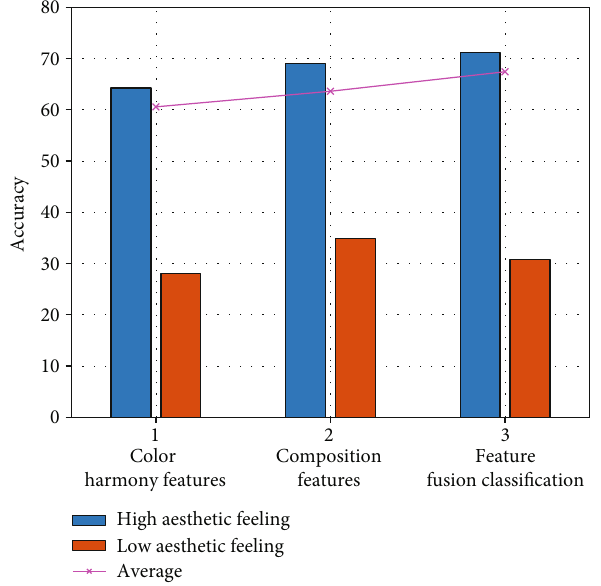
Figure 5: Color harmony features, composition features, and feature fusion classi fi cation results.